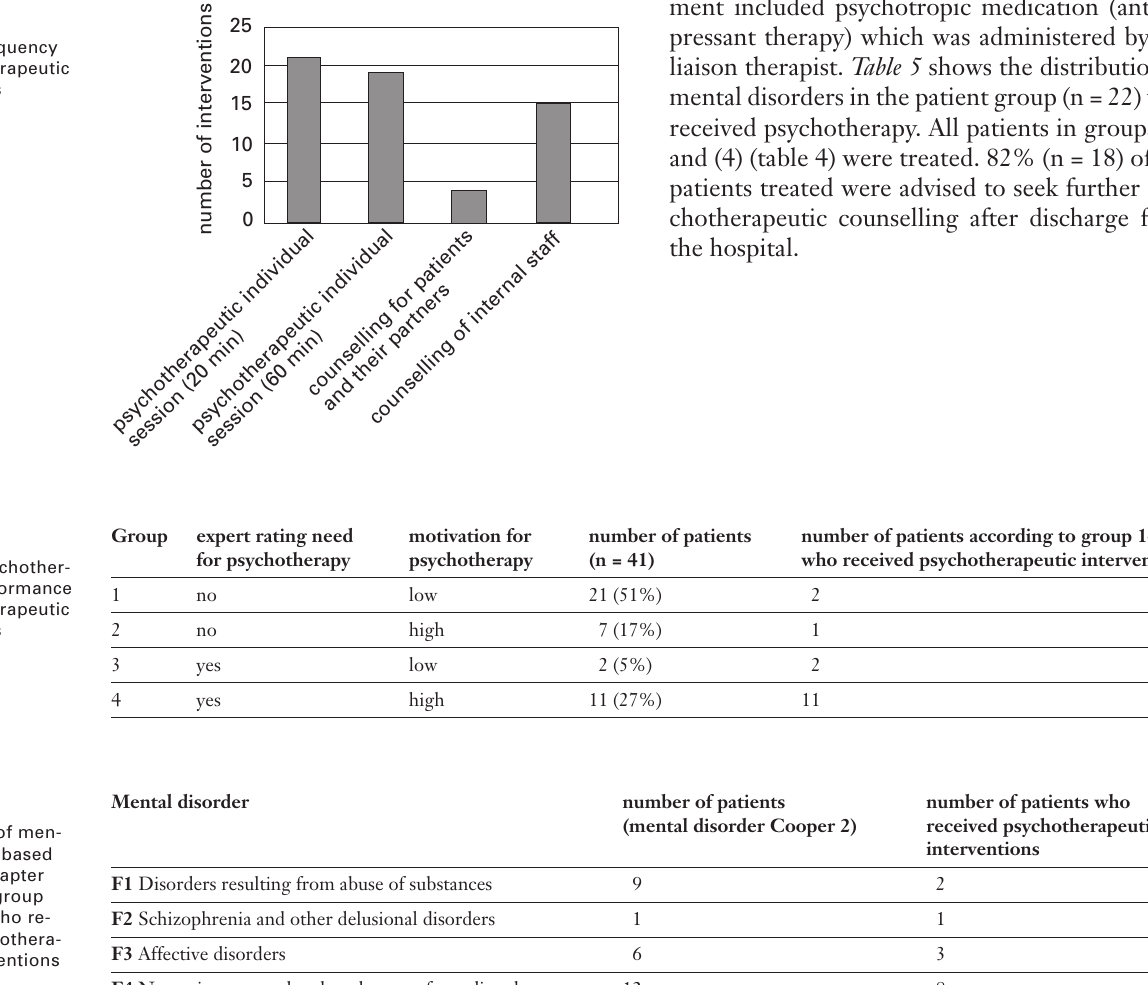
Type and frequency of psychotherapeutic interventions (n = 57).